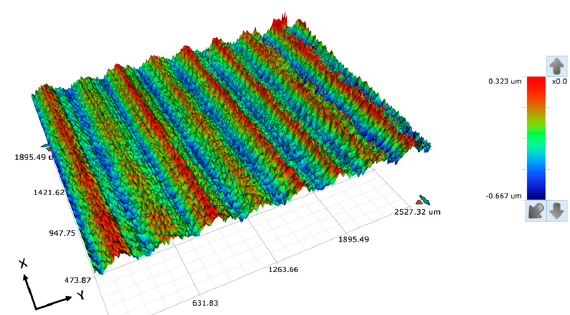
Figure 5. Planing surface topography.